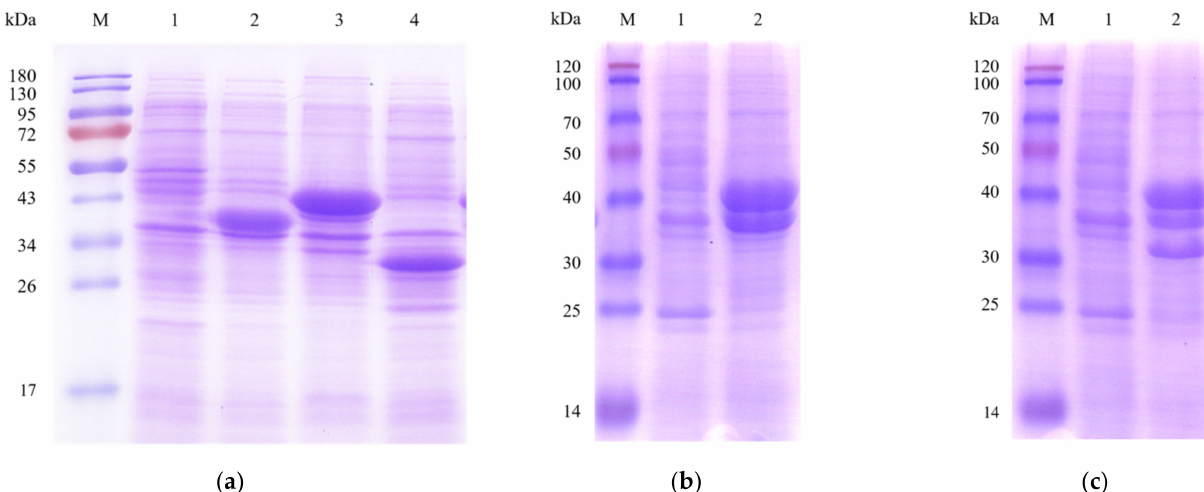
Figure 2. SDS-PAGE analysis of old yellow enzyme, alcohol dehydrogenase and glucose dehydrogenase. ( a ) Expression of YsADH, NemR-PS, or BmGDH alone. Lane M, marker; lane 1, no induction of YsADH, NemR-PS, or BmGDH as the control; lane 2, YsADH (37 kDa); lane 3, NemR-PS (39 kDa); lane 4, BmGDH M6 (31 kDa). ( b ) Co-expression of YsADH and NemR-PS. Lane M, marker; lane 1, no induction of YsADH and NemR-PS as the control; lane 2, co-expression of YsADH (37 kDa) and NemR-PS (39 kDa). ( c ) Co-expression of YsADH, NemR-PS, and BmGDH M6 . Lane M, marker; lane 1, no induction of YsADH, NemR-PS and BmGDH M6 as the control; lane 2, co-expression of YsADH (37 kDa), NemR-PS (39 kDa) and BmGDH M6 (31 kDa). The percentage of acrylamide in the resolving gel was 12%. The value in the bracket represents the apparent molecular mass of old yellow